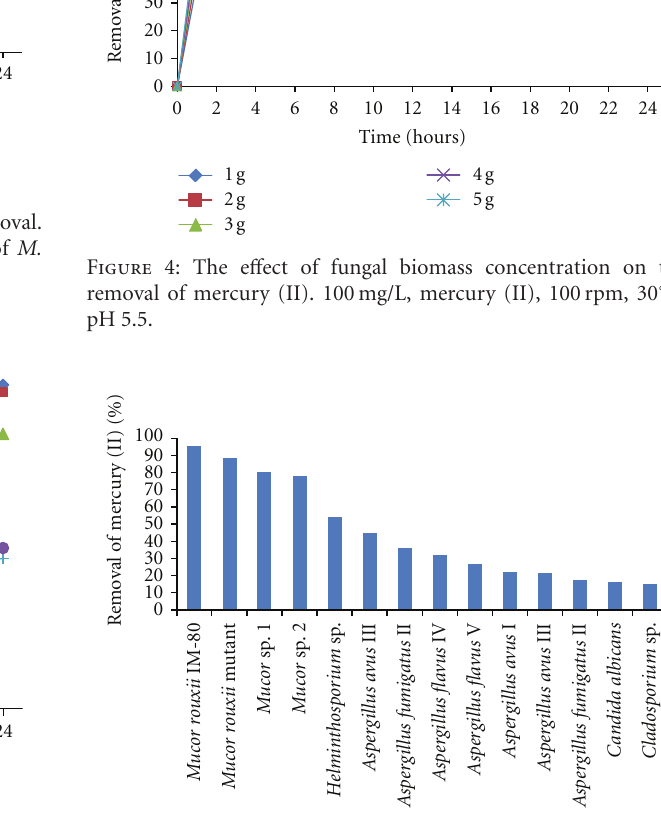
Figure 5: Biosorption of mercury (II) on di ff erent fungal biomasses. 100 mg/L Hg (II), 100 rpm, 30 ◦ C, pH 5.5, 1g of fungal